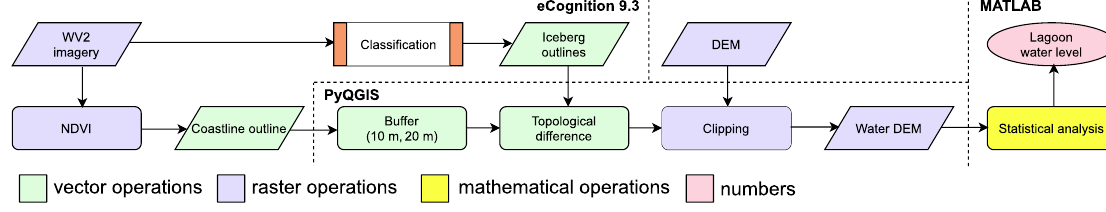
Figure 3. Procedure of determination of elevation of lagoon’s water table.